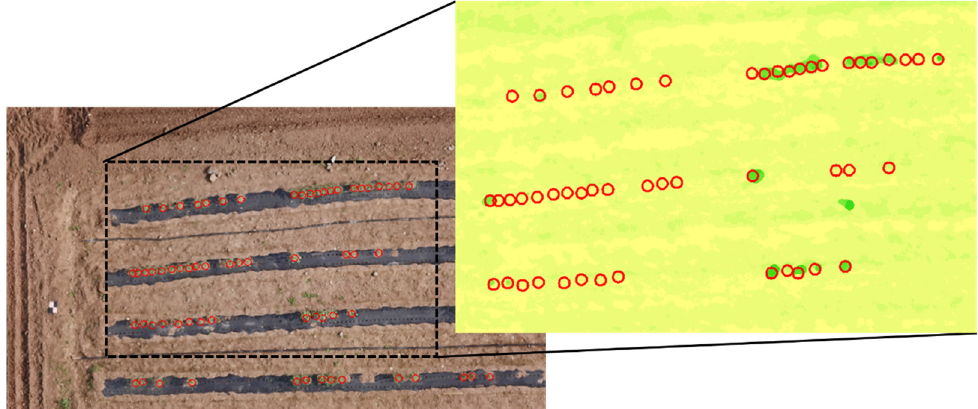
Figure 5. An example of individual height extraction. Based on the crop position from the RGB orthoimage in initial growth stages, the circles were generated. The circles were utilized in all of the growth stages.